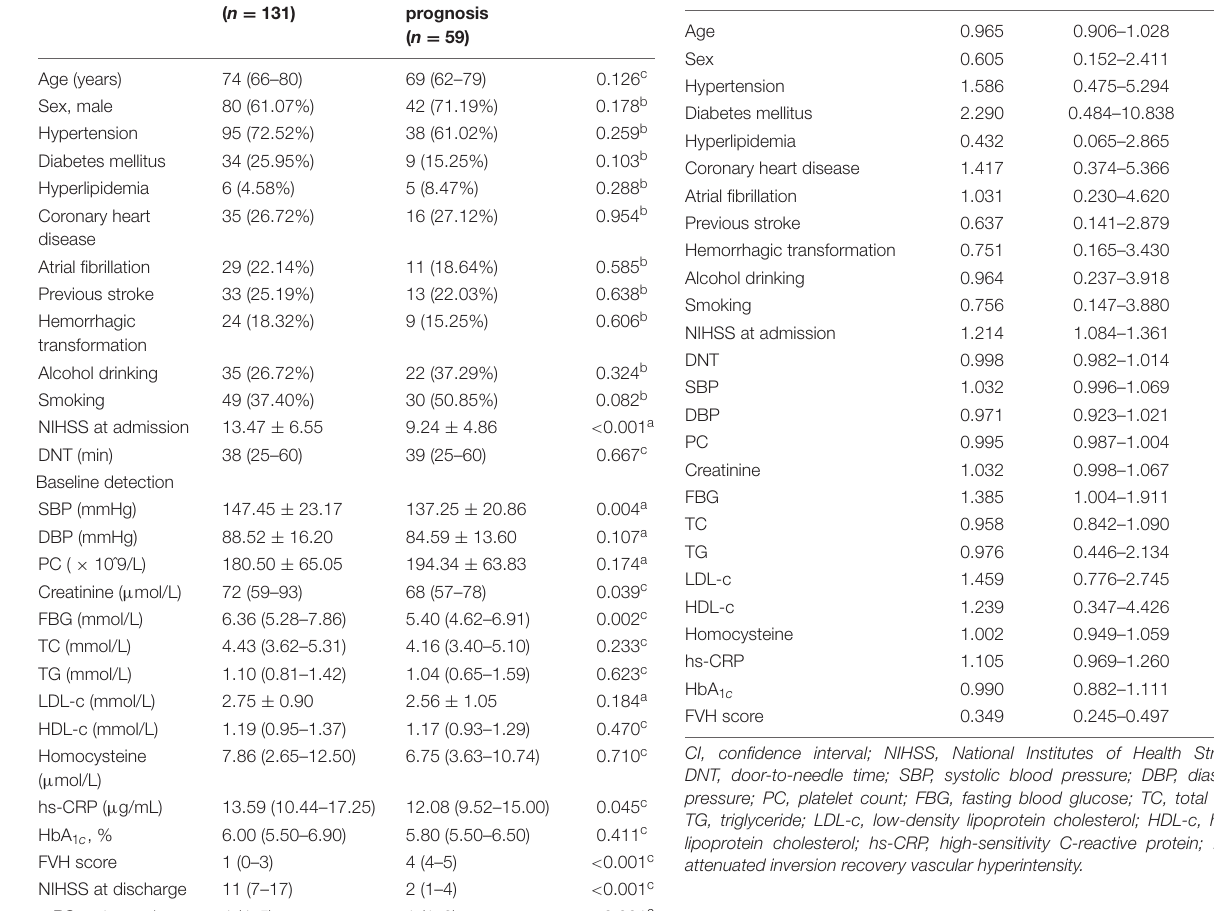
TABLE 1 | Comparison of characteristics between patients with poor and favorable prognosis after intravenous thrombolysis. Variables